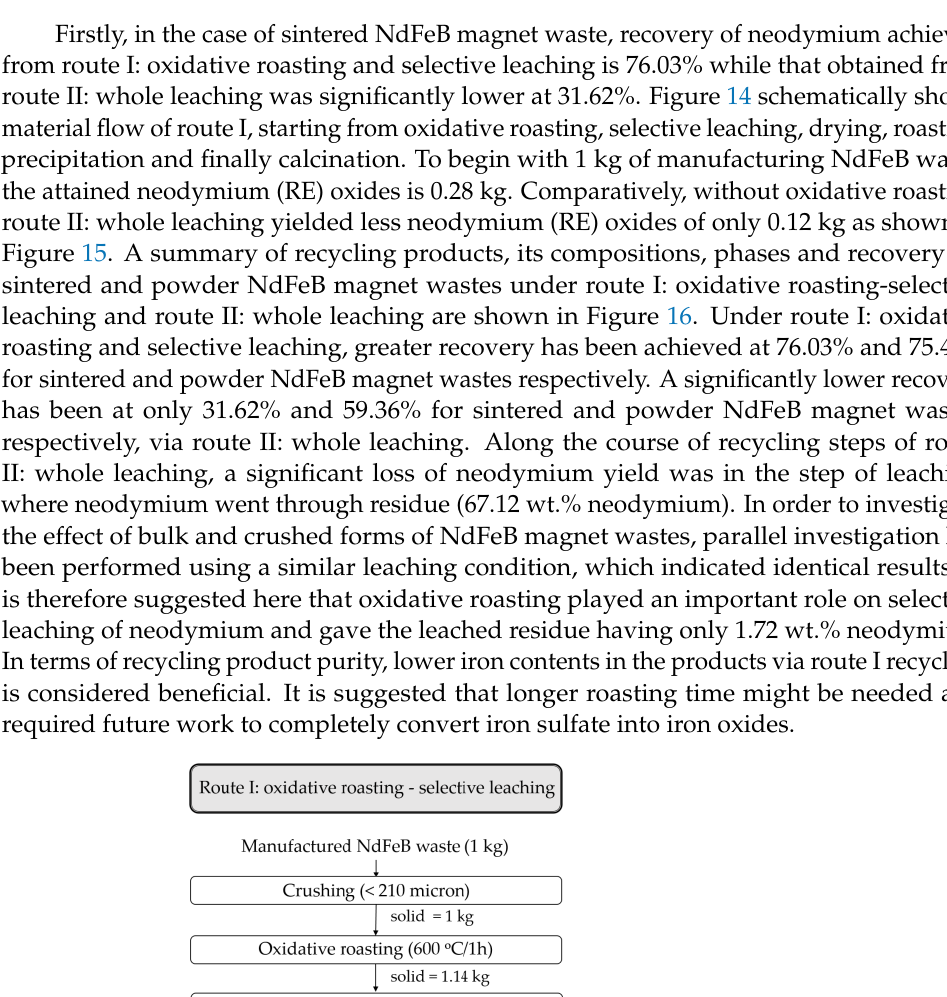
Figure 15. The material balance of sintered NdFeB recycling under route II: whole leaching.